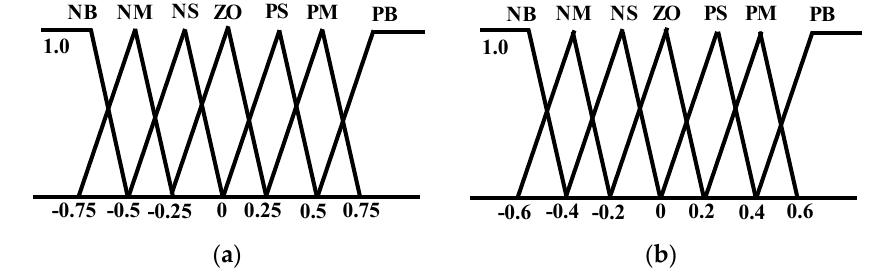
Figure 10. Membership functions for the FLC: ( a ) Inputs ( eI rd , d[eI rd ]/dt )); ( b ) output ( V rd * ).